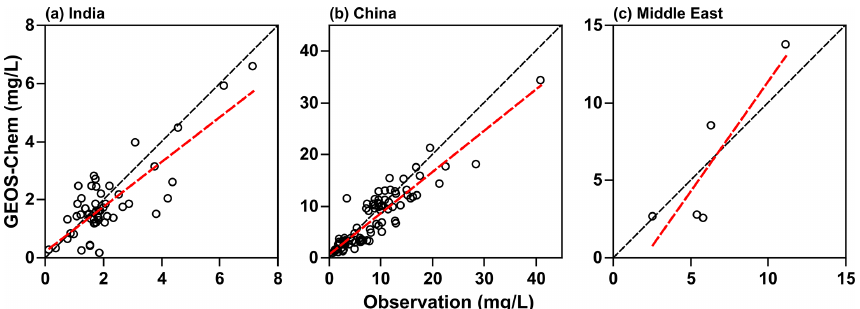
Figure 3. Scatterplot of simulated and observed sulfate rainwater concentration in (a) India, (b) China, and (c) the Middle East for 2000– 2015. The linear regression line is shown in red. The black dashed line corresponds to slope = 1. The data for the Middle East are very